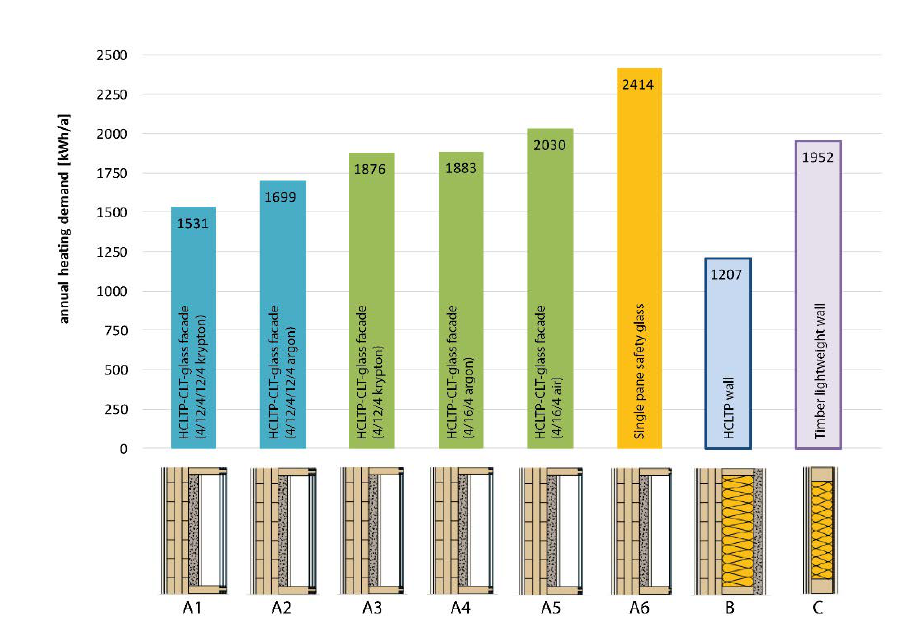
Fig. 4 Annual heating demand of the different